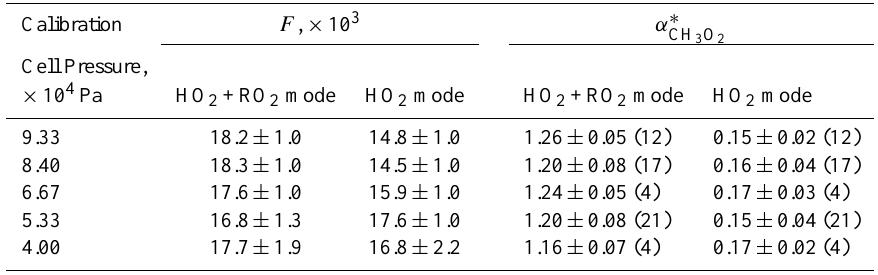
values on calibration cell pressure. 3 O 2